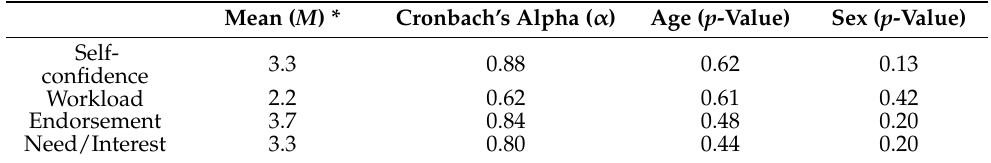
Table 5. Means, Cronbach’s alpha, and p -values of the dimensions of